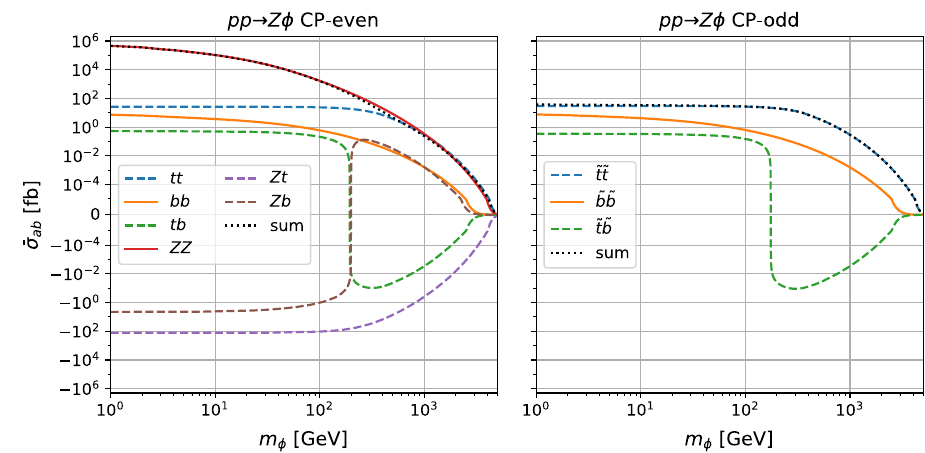
Fig. 2 Cross section contributions of Eq. (9) as a function of m φ for the process pp → Z φ at the LHC with a CM energy of 13TeV. The dashed lines indicate contributions originating entirely from the loop-induced gg → Z φ subprocess. The dotted black lines indicate the sum of the individual